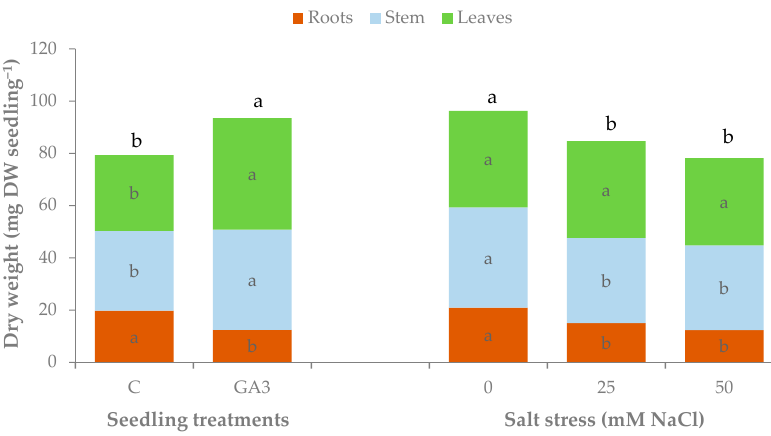
Figure 9. Effect of the seedling treatments (C, untreated control, GA3, gibberellic acid spray 10 − 5 M) and salt stress (0, 25, and 50 mM NaCl in the irrigation water) on the total, root, stem, and leaf dry weight of sweet pepper seedlings (within each experimental factor. Bars of the same color with different letters are significantly different at p < 0.05 according to the LSD test. Table 4. Effects of the gibberellic acid treatment (C, not treated; GA3, GA 3 -treated seedlings) and salt stress (0, 25, and 50 mM NaCl in the irrigation water) on leaf characteristics of sweet pepper seedlings. Leaf Area Number of Source of Variance Leaves